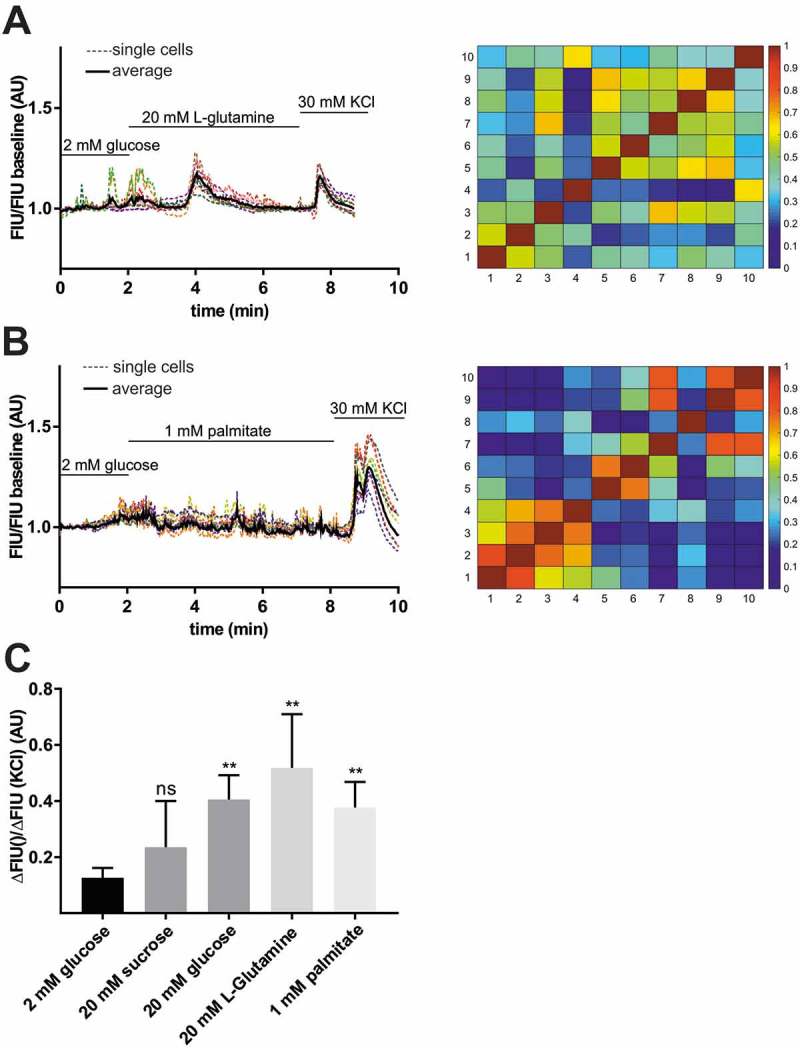
Stimulation of β-cell by L-glutamine and palmitic acid.Representative single cell GCaMP6s fluorescence traces for isolated islet from wild-type zebrafish larvae (5 dpf) after applying 2 mM glucose followed by 20 mM L-glutamine (A), and 1 mM palmitic acid (B) stimulation and 30 mM KCl. FIU intensities for the single cells (n = 10–10 cells) were determined using Image-J, normalized to the FIU baseline (intensities measured in the first 2 min when 2 mM glucose was applied) and displayed as FIU/FIU baseline (AU) for single cells (coloured dotted line) and for the average of the singles cells in the islet (black line). Cross-correlation matrices (determined by PeakCaller, MATLAB) of the islets between individual cells shown in (A) left panel and (B) left panel, with color key to the right of the matrix graph. Numbers on the x and y axes represent individual cells. Cross-correlation analysis was done on the section where L-glutamine/palmitate stimulation was applied (excluding KCl section). (C) Calcium responses to 20 mM L-glutamine and 1 mM palmitic acid when compared to 2 mM glucose. The changes in GCaMP6s fluorescence intensity in β-cells of wild-type pancreatic islets were averaged for the whole islet and the FIU peak intensity upon different nutrient stimulation was normalized to the FIU peak intensity upon KCl stimulation (n = 23, 7, 5, 4 and 7 islets were analyzed for 2 mM glucose, 20 mM glucose, 20 mM L-glutamine, 20 mM sucrose, and 1 mM palmitic acid stimulation, respectively) (in each islet at least n = 5–8 cells were analyzed and the FIU peak intensity was measured in the average FIU trace for the whole islet). Data are shown as mean values ±s.e.m., *p < 0.05 in unpaired t-test between 2 mM glucose and 20 mM sucrose, 20 mM L-glutamine, and 1 mM palmitic acid stimulation. FIU = Fluorescence Intensity Units (AU, Arbitrary Units).